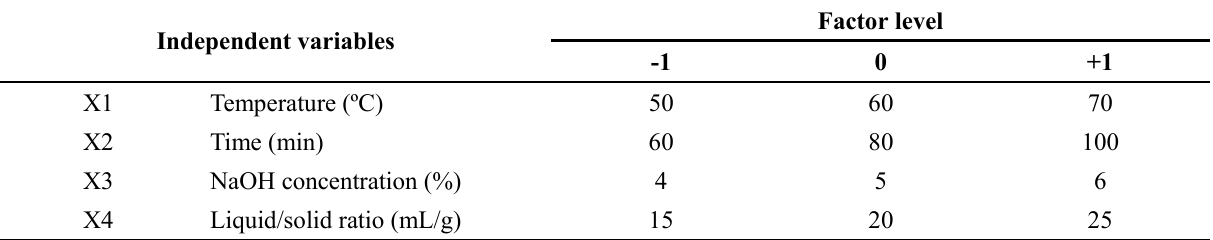
Table 6. Independent variables and factors levels in the response surface